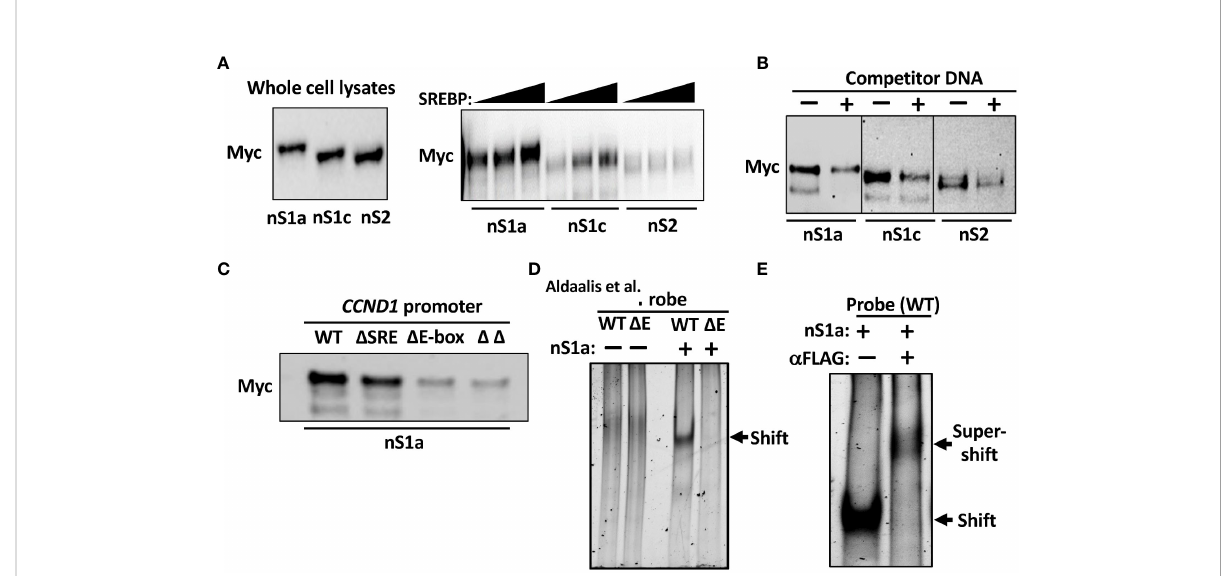
FIGURE 4 SREBP1 interacts with the human cyclin D1 promoter. (A) 6xMyc-tagged nuclear SREBP1a ( nS1a) , SREBP1c ( nS1c ), and SREBP2 ( nS2 ) were expressed in HEK293 cells and used in DNAP assays using a biotinylated DNA probe corresponding to the human cyclin D1 promoter. The three proteins were expressed at similar levels as monitored by Western blotting ( left ). Increasing amounts of the three proteins were incubated with the promoter probe, captured on streptavidin beads, washed, separated on SDS-PAGE gels, and analyzed by Western blotting ( Myc , right